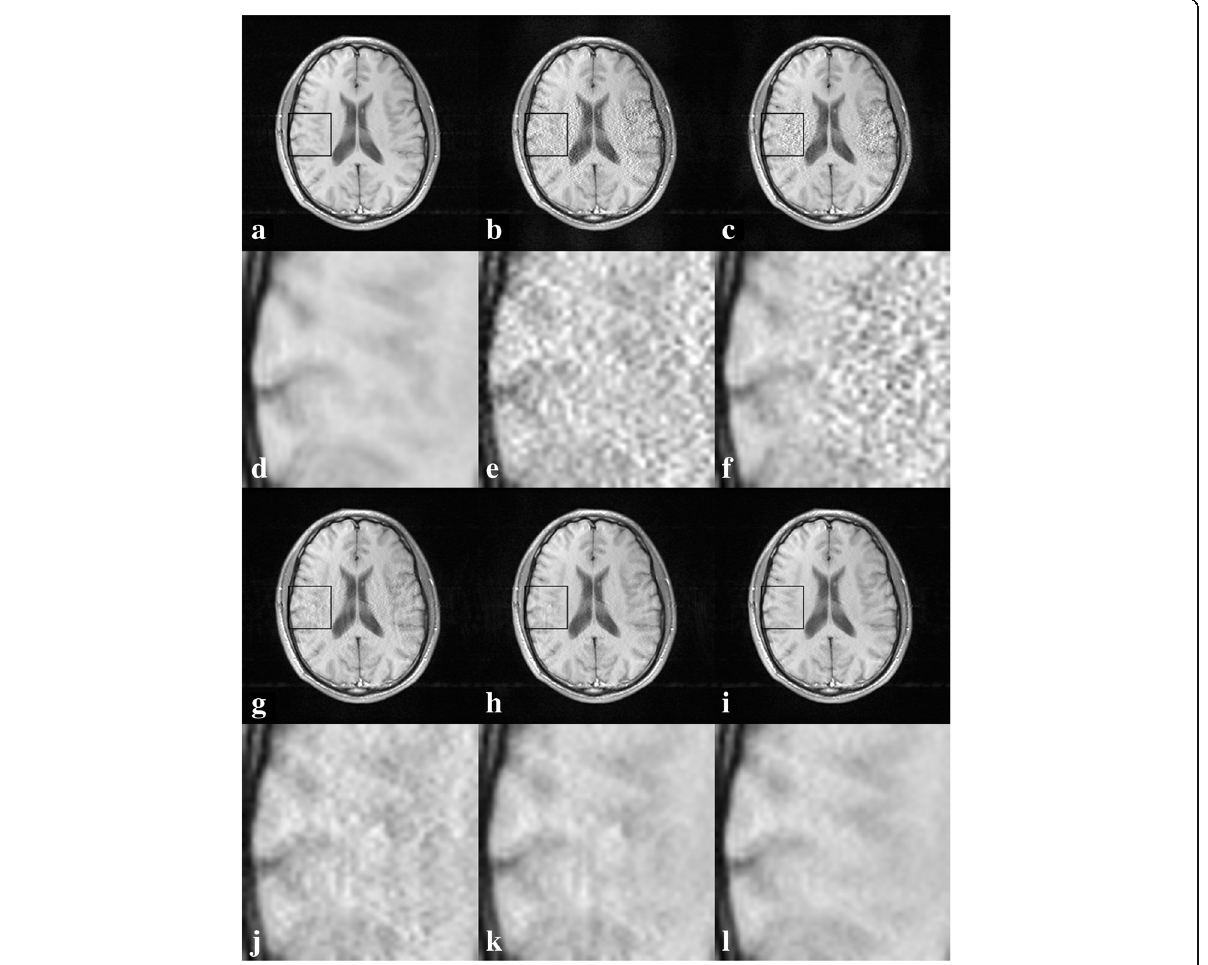
Fig. 3 Reconstructed images of a set of real four-channel axial brain data. The acquisition is accelerated with a net reduction factor of 2.56. a Reference image with SoS reconstruction. b GRAPPA reconstruction with 48 ACS lines and 4 outer reduction factor. c GRAPPA reconstruction with 22 ACS lines and 3 outer reduction factor. d Reconstruction using Tikhonov regularization. e Reconstruction using IRLS method. f Reconstruction using AV-GRAPPA. g – l Patches extracted from the same position in a – f , respectively. AV-GRAPPA is able to achieve high SNR while still keeping the image from blurring boundary. On the other hand, other methods reconstruct the image with noise more or